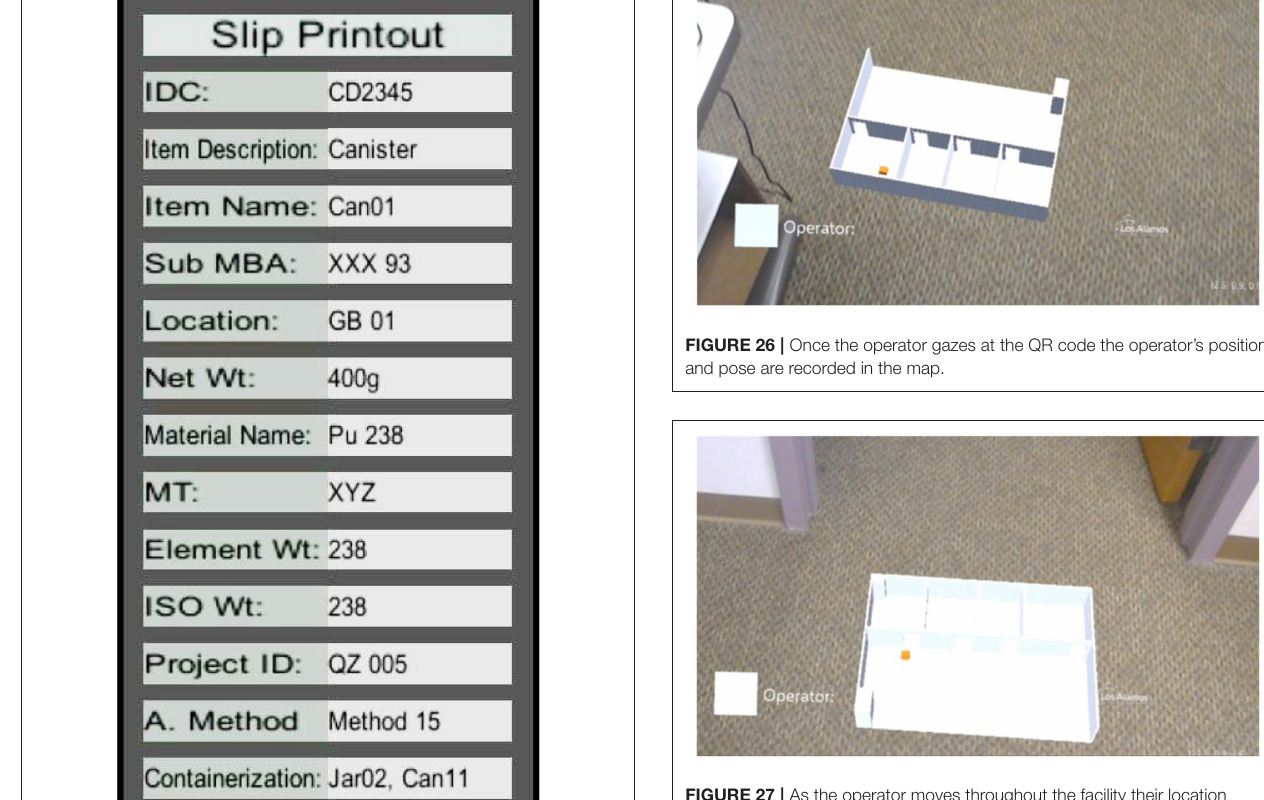
FIGURE 27 | As the operator moves throughout the facility their location relative to the map also changes.